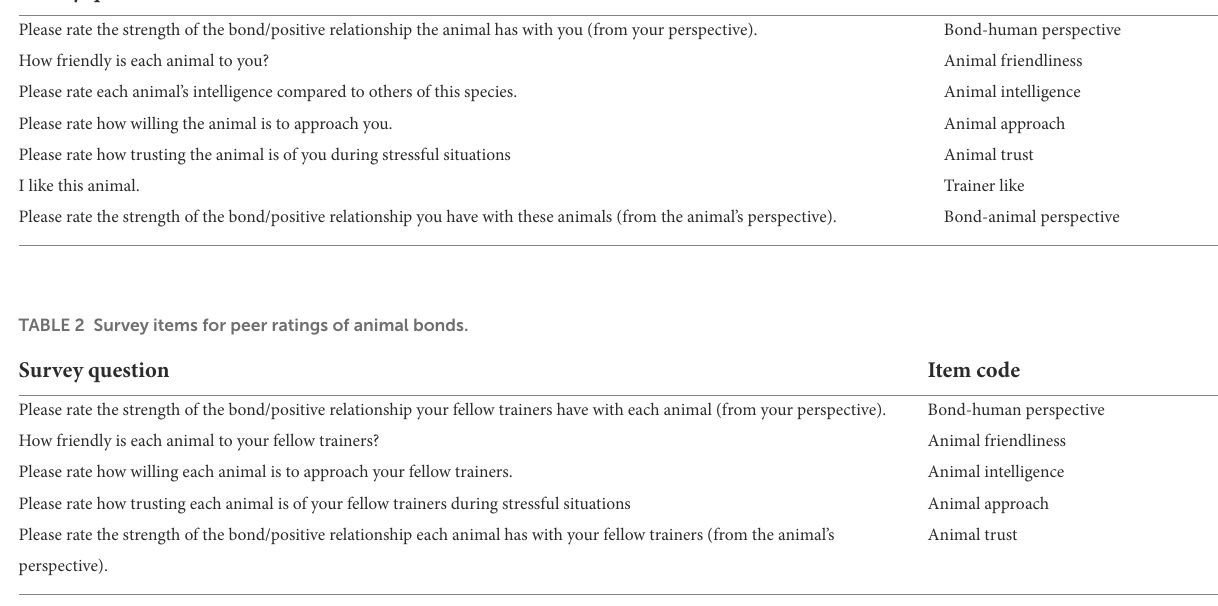
TABLE 1 Survey items for self-ratings of bonds and feelings towards each animal. Survey question